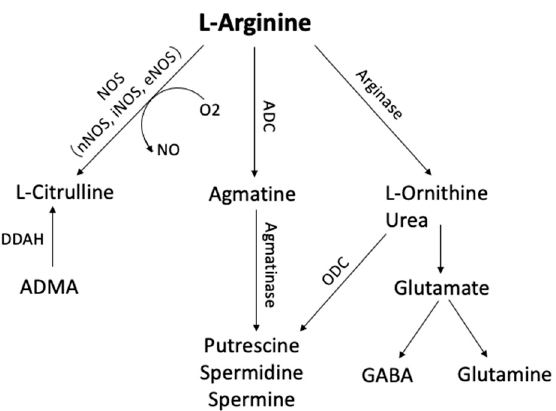
Figure 5. Arginine metabolic pathways. L-arginine can be metabolized by phosphatidic acid (PA), nitric oxide synthase (NOS), arginase, and arginine decarboxylase (ADC) to form several bioactive molecules. (ADC, Arginine decarboxylase; ADMA, NG-dimethyl-L-arginine; DDAH, dimethylargi- nine dimethylaminohydrolase; GABA, γ -aminobutyric acid; ODC, ornithine